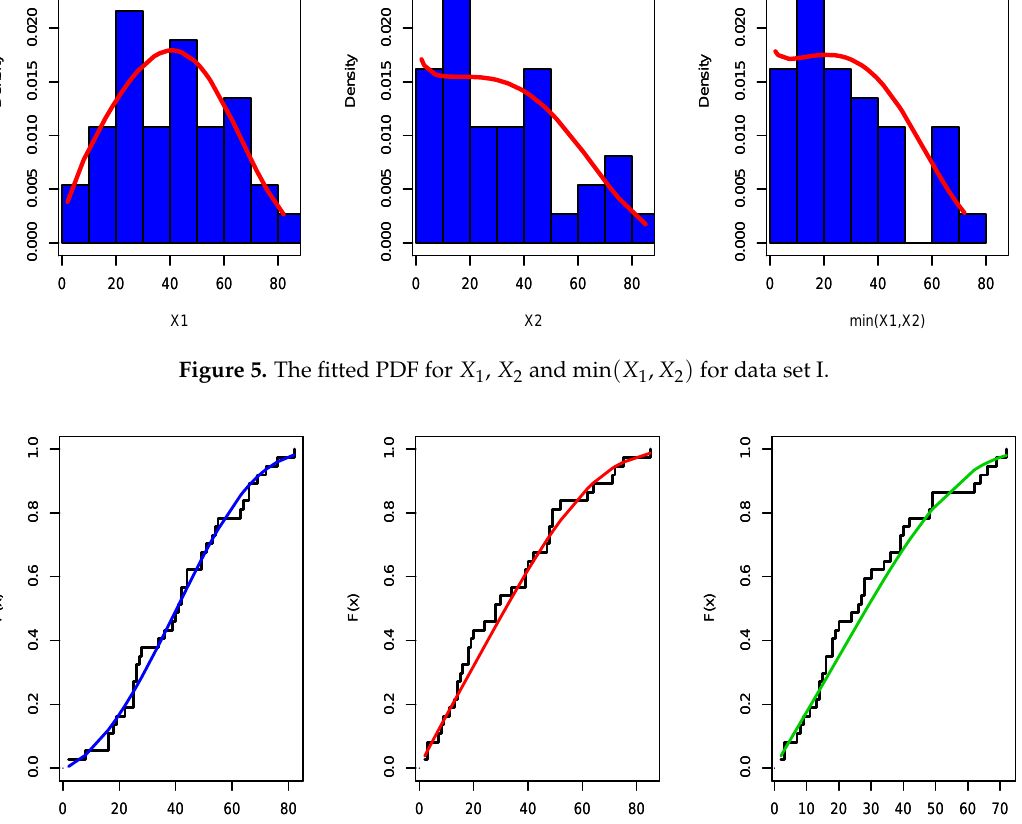
Figure 6. The estimated cumulative distribution function (CDF) for X 1 , X 2 and min ( X 1 , X 2 ) for data set I.